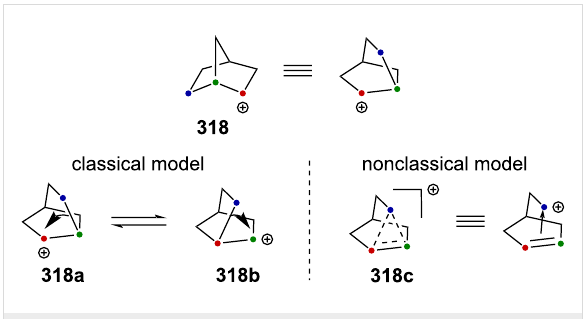
Figure 12: Structure of 2-norbornylcarbenium ion 318 and argued model for the stabilization of this